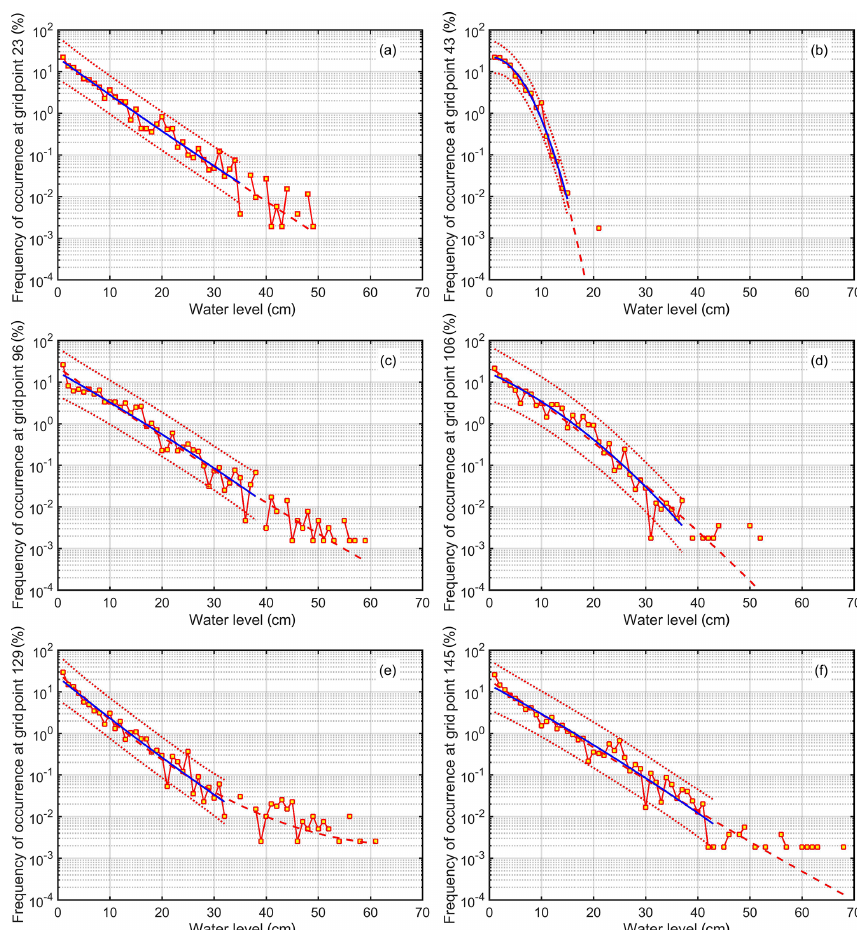
Figure 7. Simulated distributions of various set-up heights (red squares) at various locations in the Tallinn Bay area open to different directions. Blue line: interpolation with a quadratic function from the set-up height of 0.01m to the first gap in the empirical distribution; red dotted lines: its 95% confidence intervals; red dashed line: similar interpolation using all data points. The interpolating lines evaluated using only the data points from 0.01 to 0.4m are fully masked by blue lines. The resolution of all distributions is